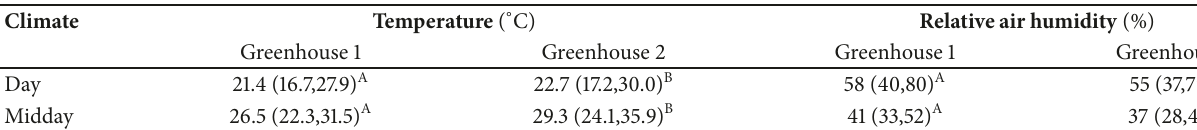
Table 2: Climatic conditions represented by temperature and relative air humidity during day (5 am–9 pm; n = 1020) and midday (11 am–2 pm; n = 60) in greenhouses 1 and 2 in June 2014. Values represent the median and interquartile ranges (IQR = first quartile, third quartile). Uppercase letters indicate significant differences of temperature and relative air humidity between the greenhouses using Mann-Whitney U test ( p < 0.05).